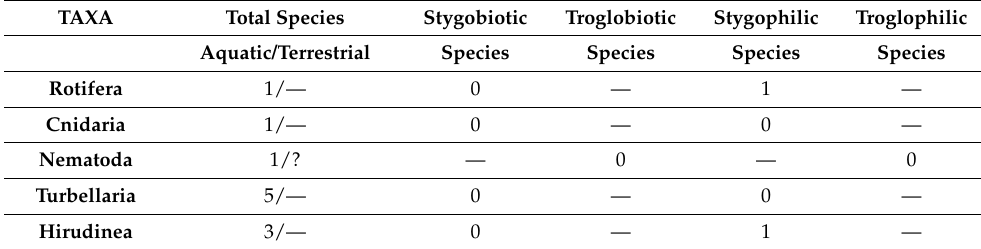
Table 1. Number of taxa known in the Ojo Guareña Natural